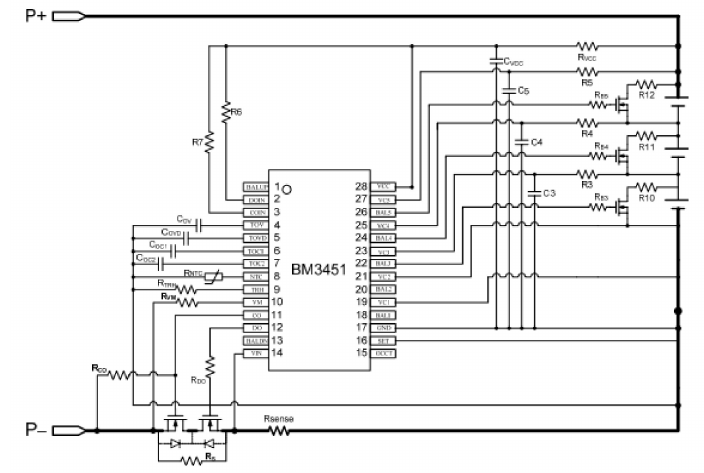
Figure 6. BM3451 with three-cell application with balance